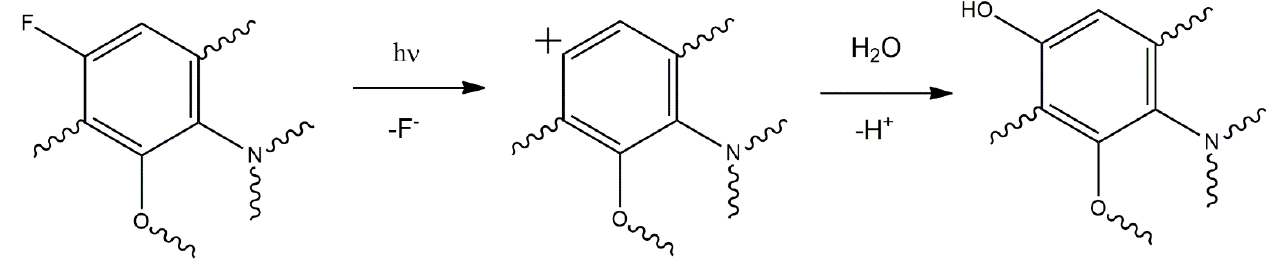
Figure 8. Nucleophilic substitution of fluorine via photogenerated aril cation intermediate. The m/z value of 362 corresponds to the (M + 1) peak of OFL with the retention time (F) of OFL in accordance with the MS 2 degradation spectrum. The m/z value of 322 corre- sponds to the A oxidized photoproduct according to MS 2 fragmentation spectra [20]. The